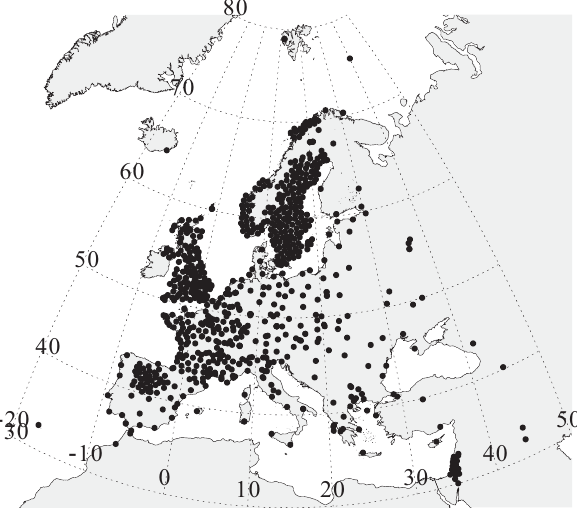
Fig. 1. Location of the GPS receivers in